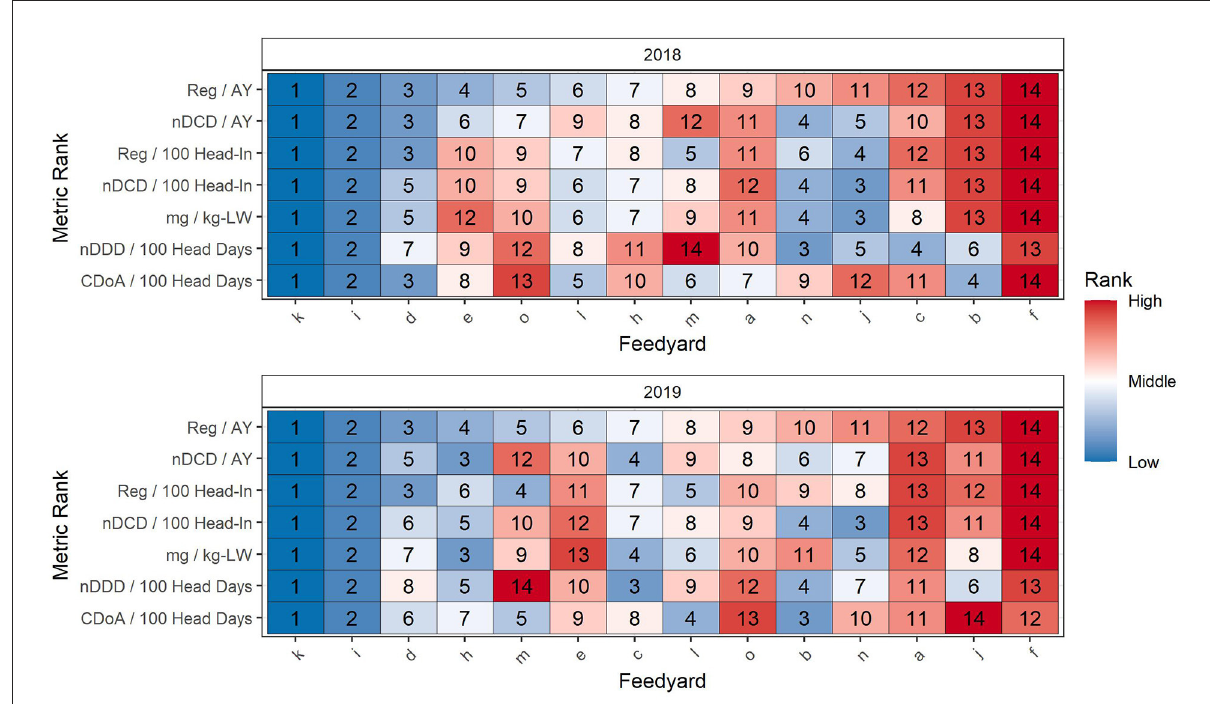
FIGURE8 Comparison of feedyard antimicrobial use ranking by 7 metrics. Rank 1 is the lowest and rank 14 is the highest value. The feedyards are ranked on the X axis by their rank according to Reg/AY. Color coincides with numerical rank within each metric (row) as illustrated to the right of the figure.